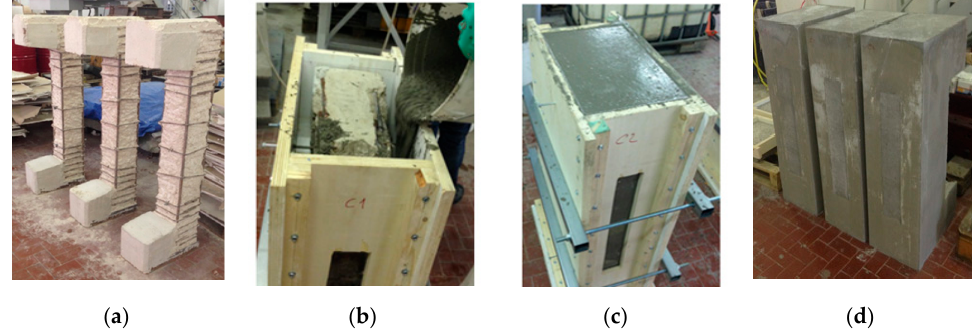
Figure 2. Details of the HPFRC jacketing application to the as-built RC columns: concrete cover removal ( a ), fresh HPFRC pouring and curing ( b , c ), and the specimens after formwork removal ( d ).